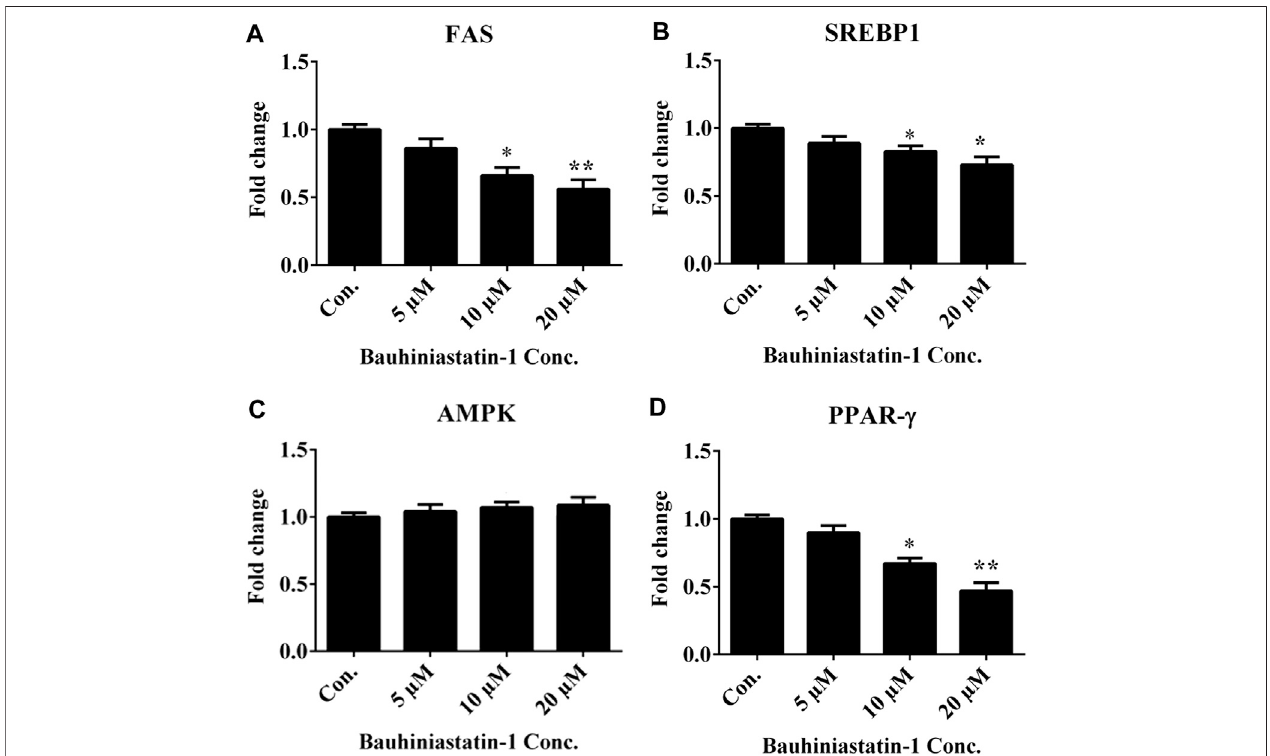
FIGURE3| EffectofBSTN1onmRNAexpression oftargetgenesin3T3-L1cellsbyRT-PCR. Quantitation offoldchangeofkeyadipogenicandlipogenicmarkers (A) FAS mRNA (B) SREBP1 mRNA, (C) AMPK mRNA and (D) PPAR- γ mRNA. Data are presented as mean ± SD of triplicate. * and ** indicate signi fi cant difference between control and treated 3T3-L1 cells at p < 0.05 and p < 0.01, respectively. FAS, fatty acid synthase; SREBP1, sterol regulatory element-binding protein 1; AMPK, AMP-activated protein kinase and PPAR- γ , peroxisome proliferator-activated receptor- γ .